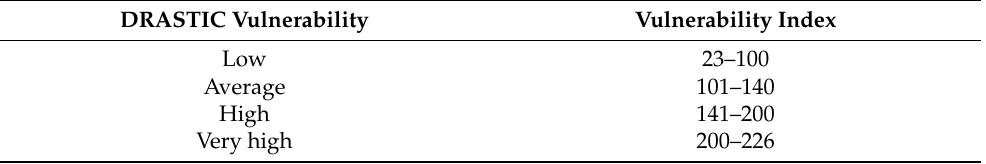
Table 1. Evaluation classes of vulnerability degree using the DRASTIC